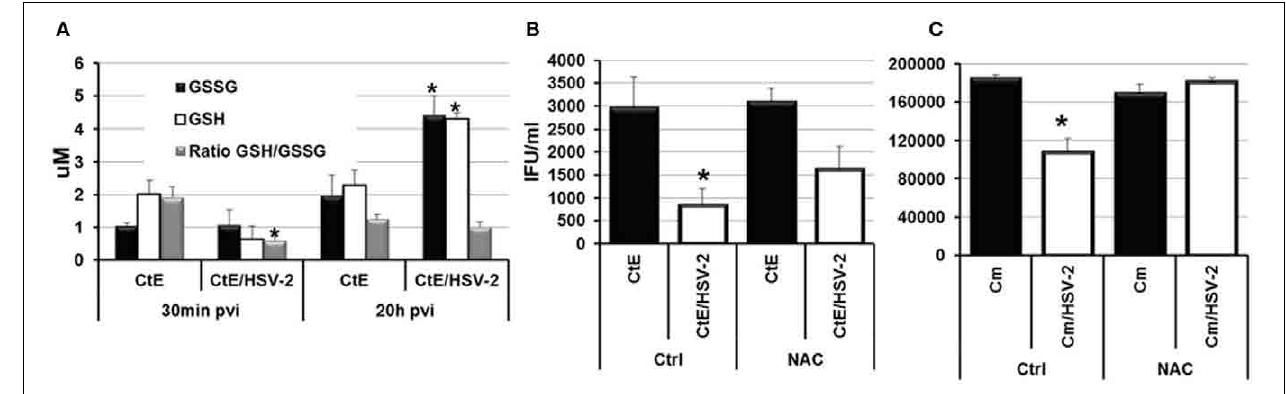
FIGURE 5 | N-acetyl cysteine exposure during Chlamdyia /HSV-2 co-infection rescues EB production during Chlamydia /HSV-2 co-infection. (A) Triplicate HeLa monolayers were either CtE- or CtE/HSV-2-infected. Monolayers were harvested at 30min and 20h pvi for quantification of GSH and GSSG. (B) Triplicate HeLa monolayers were either CtE- or CtE/HSV-2-infected. (C) Triplicate HeLa monolayers were either Cm-